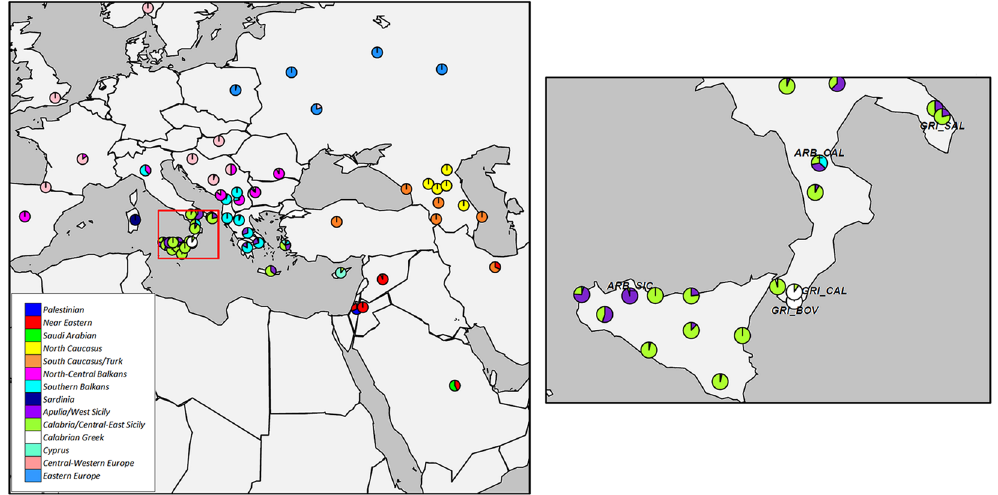
Figure 3. Clustering of the 1,366 modern Euro-Mediterranean individuals into 14 genetic-based clusters as inferred by ChromoPainter/fineSTRUCTURE analysis. At the considered hierarchical level of K = 14, each cluster has at least 10 members. For each of the analysed populations, the relative proportions of inferred genetic clusters are summarized by corresponding pie charts. Cluster names are detailed in the legend at the bottom-left of the plot. The geographical map has been plotted using the R software [v.3.2.4] (R: A Language and Environment for Statistical Computing, R Core Team, R Foundation for Statistical Computing, Vienna, Austria (2016)